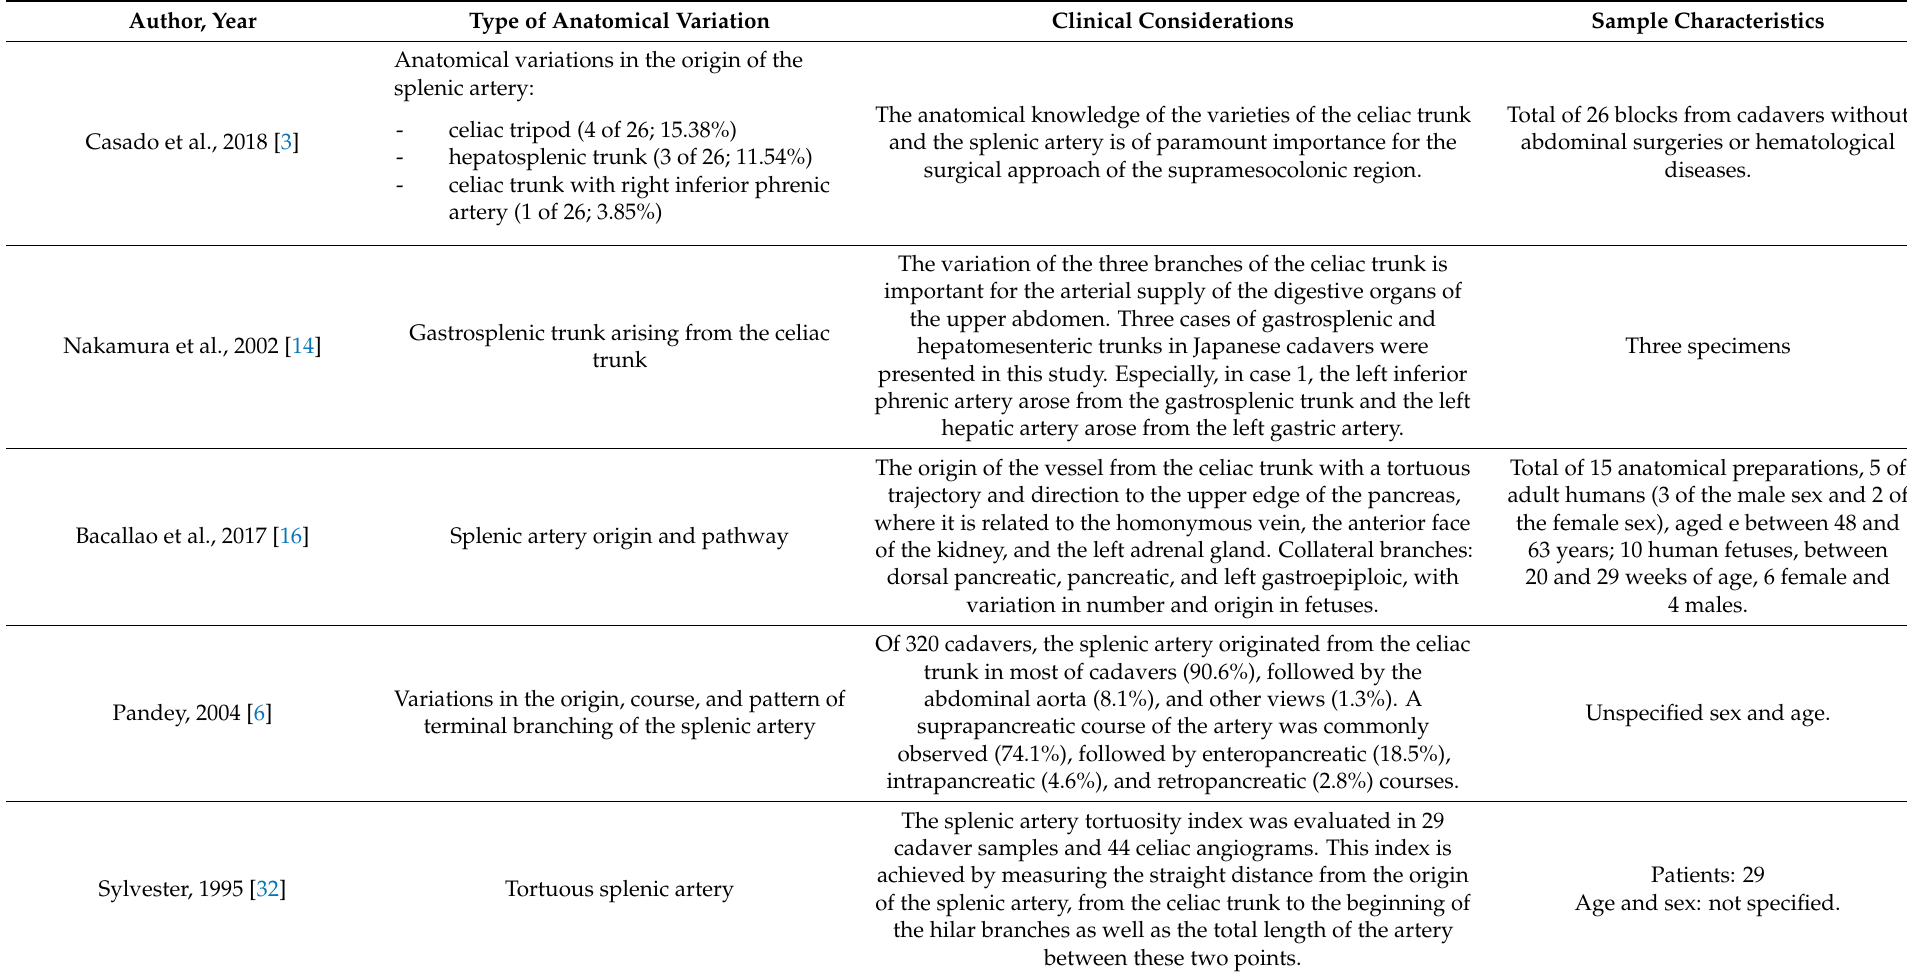
Table 4. Summary of the described variations and their clinical correlations of the included